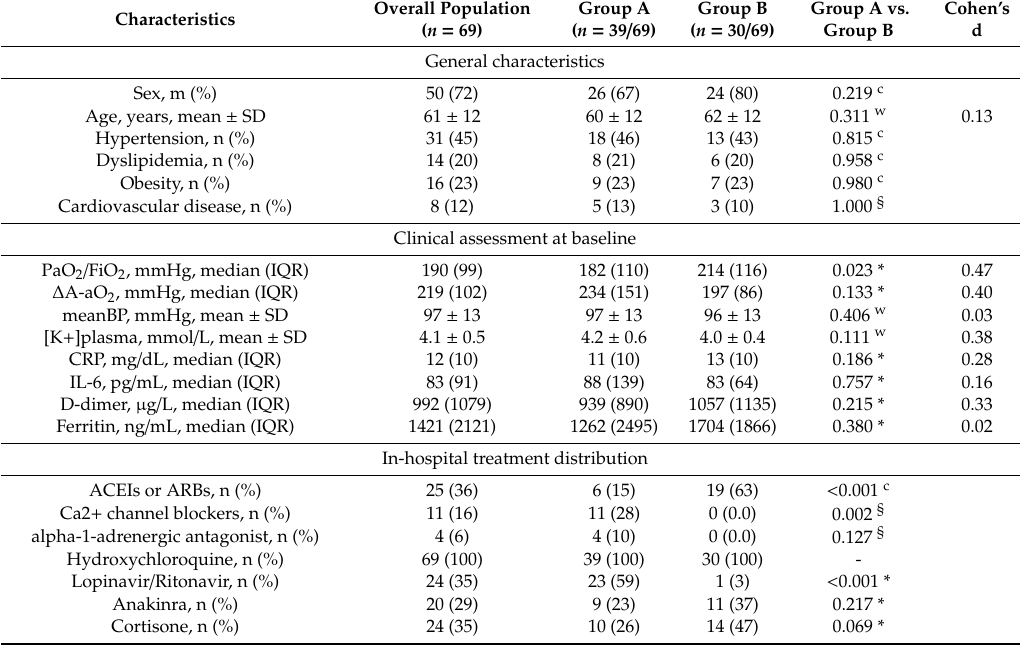
Table 1. Patients’ general characteristics, clinical parameters, and treatment distribution at